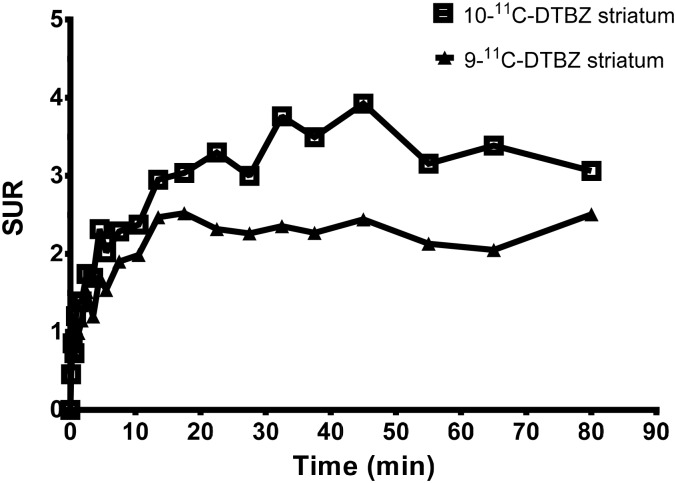
The SUR comparison of 9-(+)-11C-DTBZ and 10-(+)-11C-DTBZ in a rat brain.